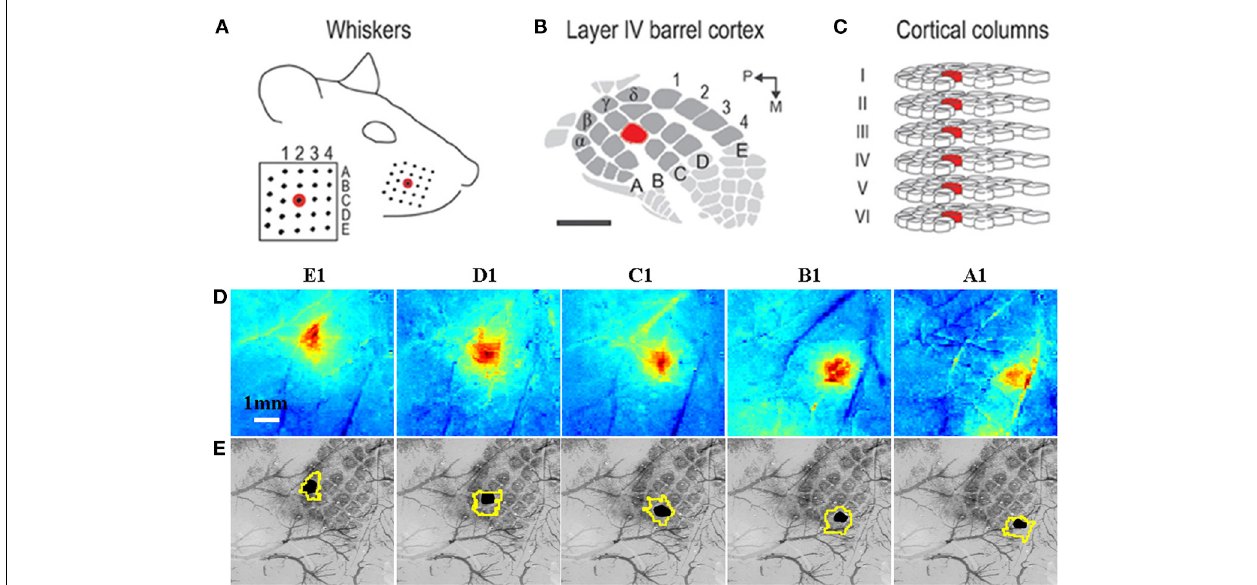
FIGURE 3 | Grid-like arrangement of the rodent facial whiskers (A) is topographically preserved with mapping in somatosensory cortex (B) of individual whiskers to individual cortical columns (C). (A–C) adapted from Chen-Bee et al. (2012). (D) Measurement of total hemoglobin concentration changes during stimulation of individual whiskers (A1–E1) produces spatiotemporal activation maps that allow spatial discrimination of activation